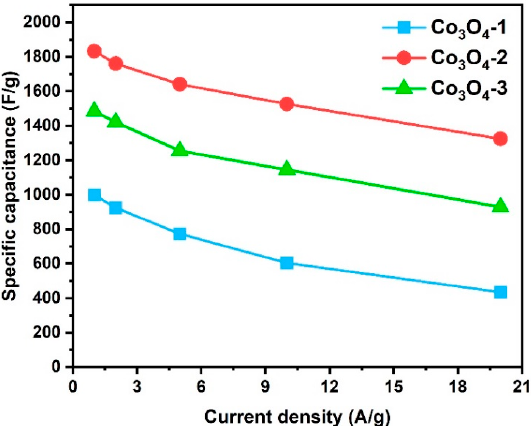
Figure 5. Specific capacitances of Co 3 O 4 -1, Co 3 O 4 -2 and Co 3 O 4 -3 electrodes as a function of current densities.